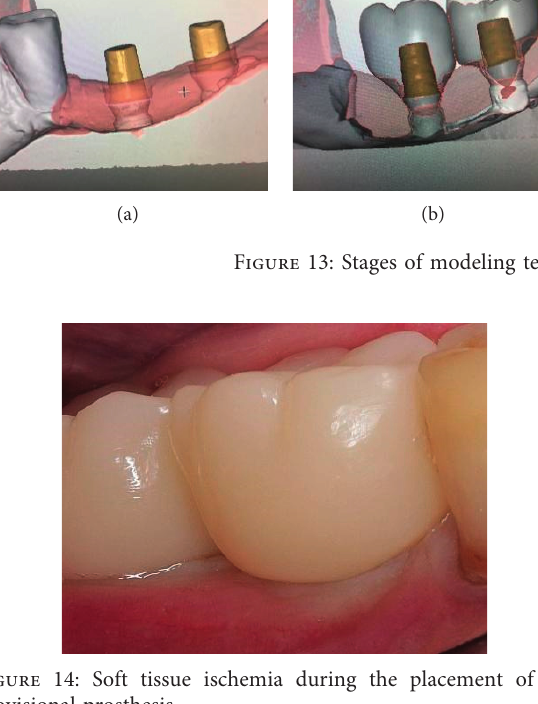
Figure 16: Contamination of the gingiva former.